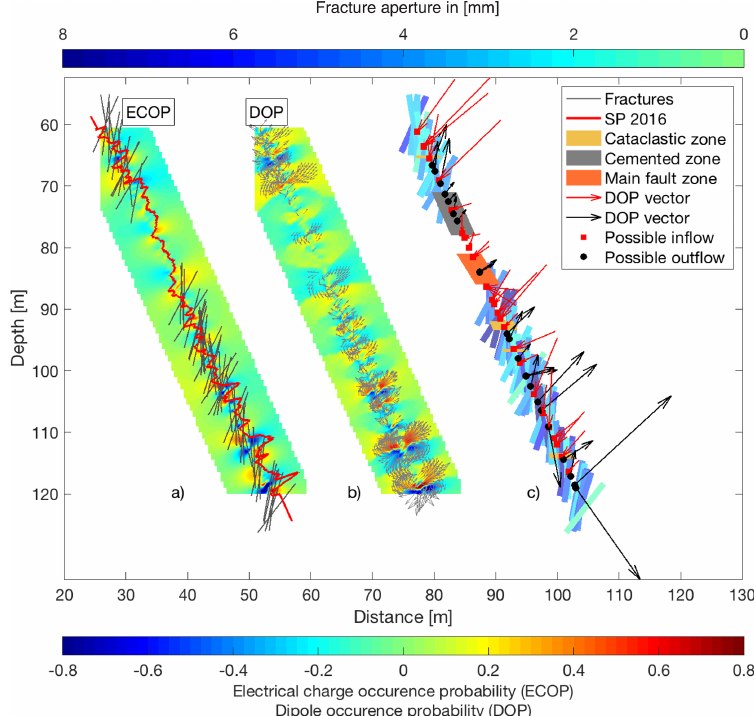
Figure 12. (a) Electric charge occurrence probability (ECOP) and (b) dipole occurrence probability (DOP) maps along the borehole track overlain by the SP log and fractures from OTV data, and DOP vectors with an absolute probability larger than 0.15, respectively. (c) Most probable DOP vectors in each 1.2m interval mapped onto the borehole track together with a projection of fracture planes and their color- coded